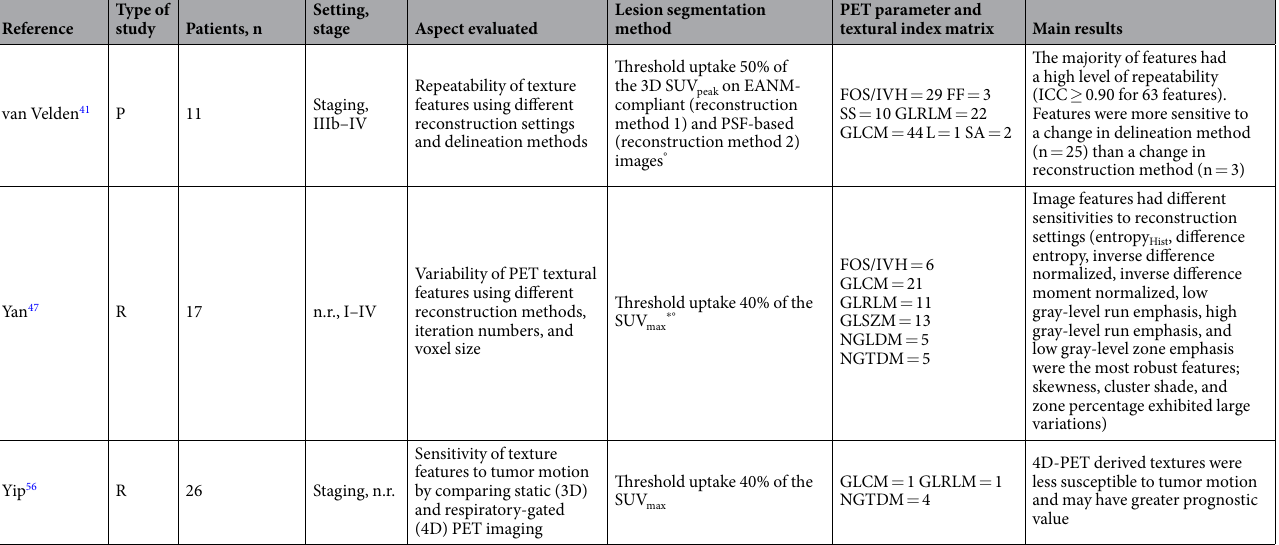
Table 1. Publications reporting methodological investigations on texture analysis in NSCLC patients. FF: fractal features; FLAB: fuzzy locally adaptive Bayesian; FOS/IVH: first-order statistics/intensity-volume histogram; GLCM: gray-level co-occurrence matrix; GLRLM: gray-level run-length matrix; GLSZM: gray- level size-zone matrix; Gr: absolute gradient; ICC: intra-class correlation coefficient; L: Laplacian; LF: Laws family; n.a.: not available; n.r.: not reported; NGLDM: neighboring gray-level dependence matrix; NGTDM: neighborhood gray-tone difference matrix; P: prospective; R: retrospective; SA: spatial autocorrelation; SS: shape and size; W: wavelet * Segmentation of only primary lung lesion. # Segmentation of lymph nodes. § Segmentation of primary lung lesion and other tissues (e.g. lymph nodes). °Included in the analysis only lung lesion with a volume > of a minimum cut-off (e.g. 3